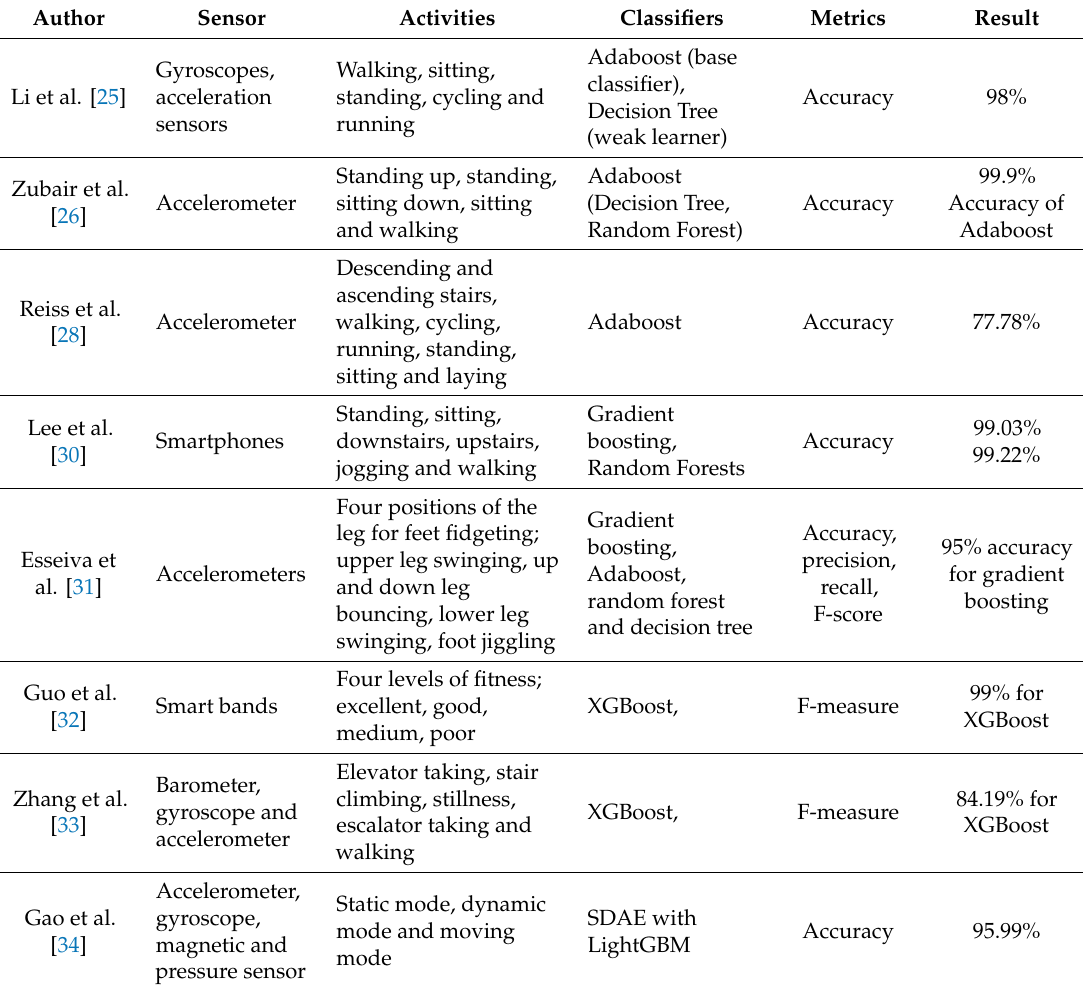
Table 1. Overview of the physical activity classification systems developed using boosting